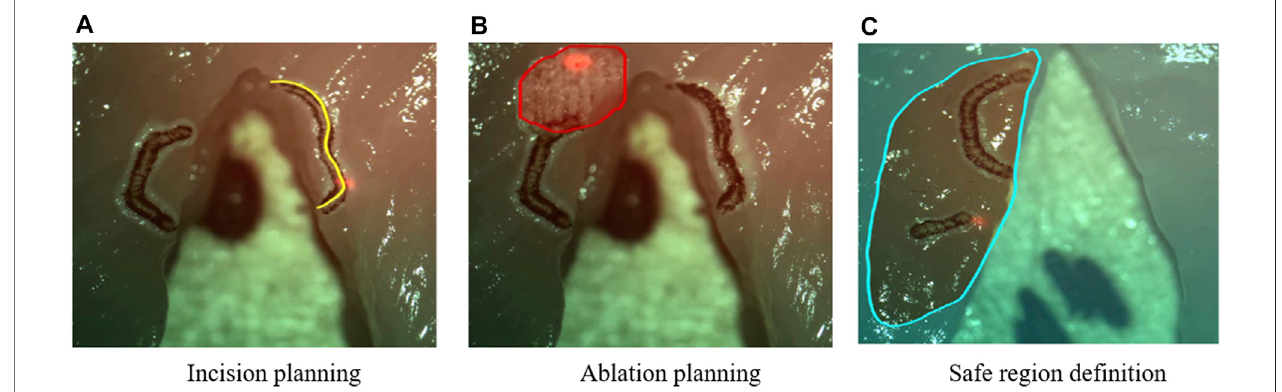
FIGURE 9 | Examples of intra-operative planning of incisions paths, ablation patterns, and safety regions based on graphic overlays (Deshpande et al., 2014). The high-power surgical laser was only enabled within the de fi ned safe region.